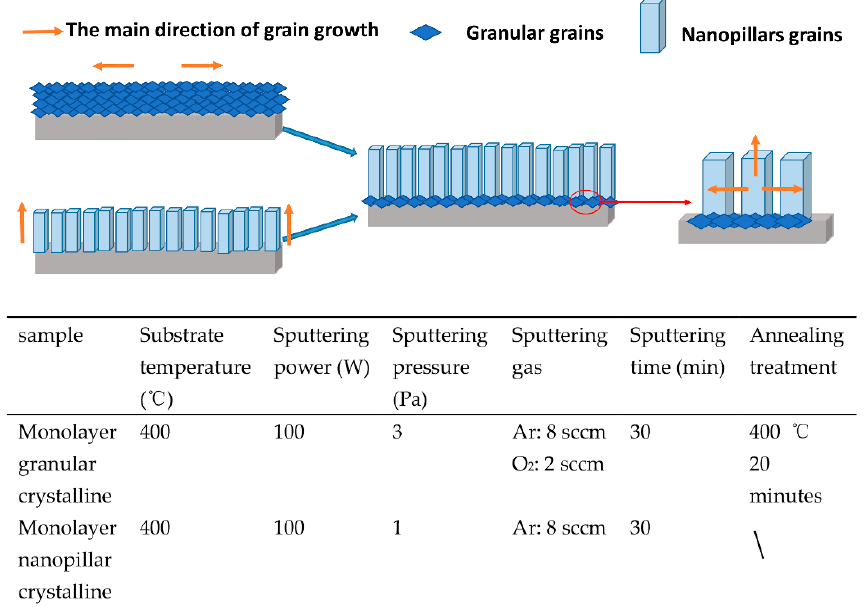
Figure 1. Schematic diagram of multiple structure nanopillar crystalline film, the preparation parameters of monolayer granular crystalline film and monolayer nanopillar crystalline film.